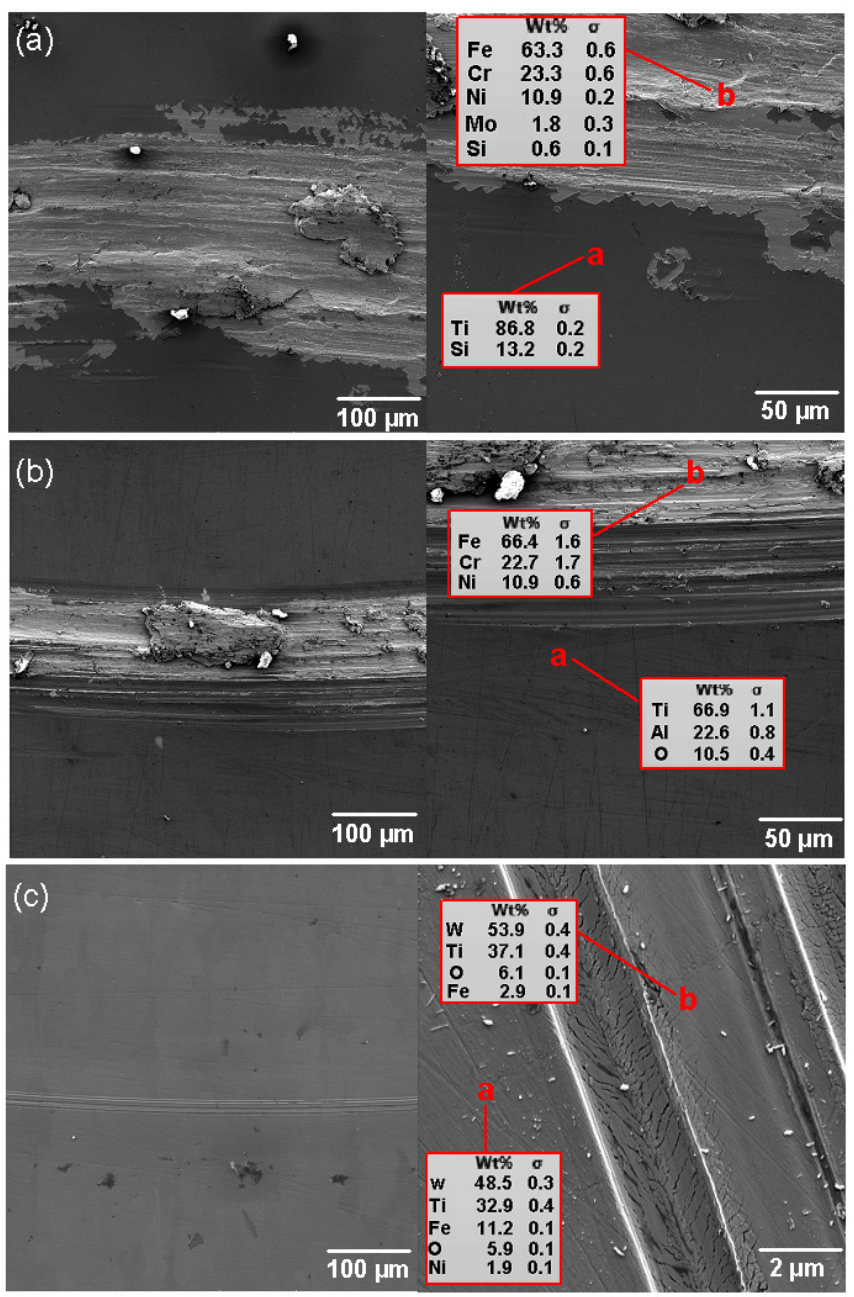
Figure 5. SEM and EDS micrographs of the wear traces of the coatings of ( a ) TiSi, ( b ) AlTi, and ( c ) WTi.